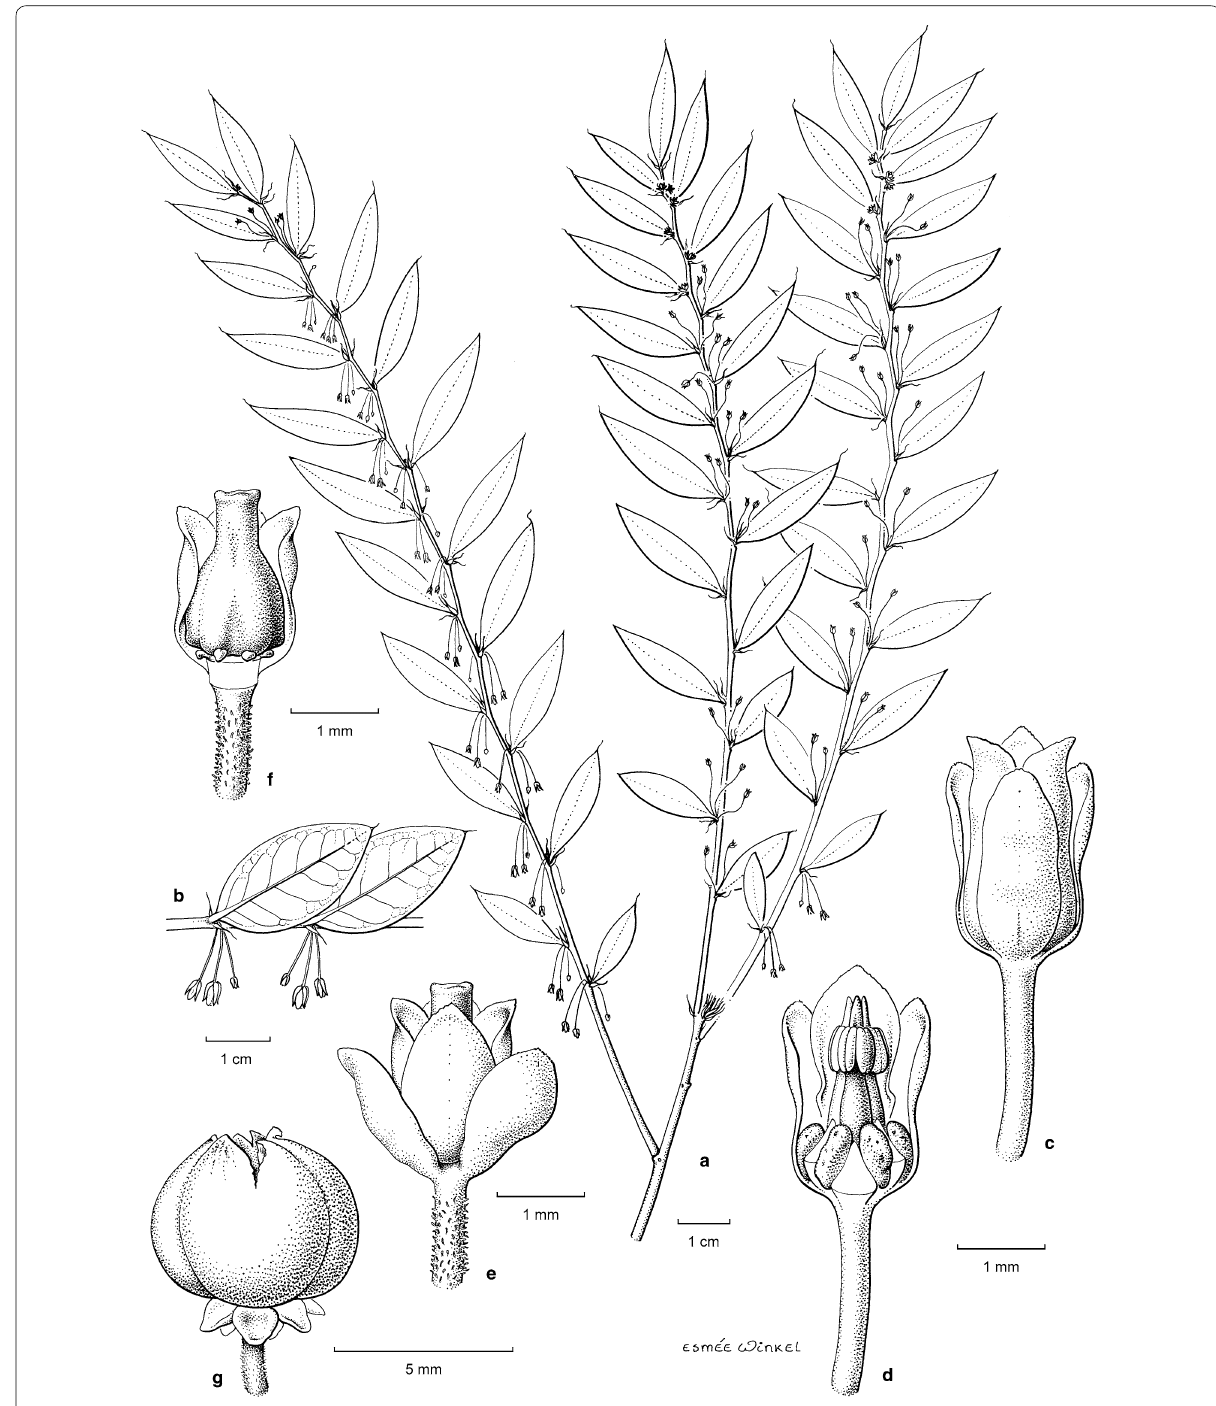
Fig. 3 Phyllanthus rufuschaneyi Welzen, R.W.Bouman & Ent: a a branch with only scars of cataphylls and cataphyllary stipules present at the base of branchlets as these are caducous (drawn from herbarium specimen with leaves glued sideways and staminate flowers sometimes upright instead of hanging); b detail of sidebranch with leaves and staminate flowers in natural position; c staminate flower; d staminate flower with part of sepals removed showing disc glands and androecium; e pistillate flower; f pistillate flower with part of sepals removed showing disc glands and ovary; g fruit ( a , c , d Daim Endau 225 ; b Lomudin Tadon g257 ; e , f SNP 32987 ; g Lomudin Tadon 257 ; all SNP). Drawing by Esmée Winkel